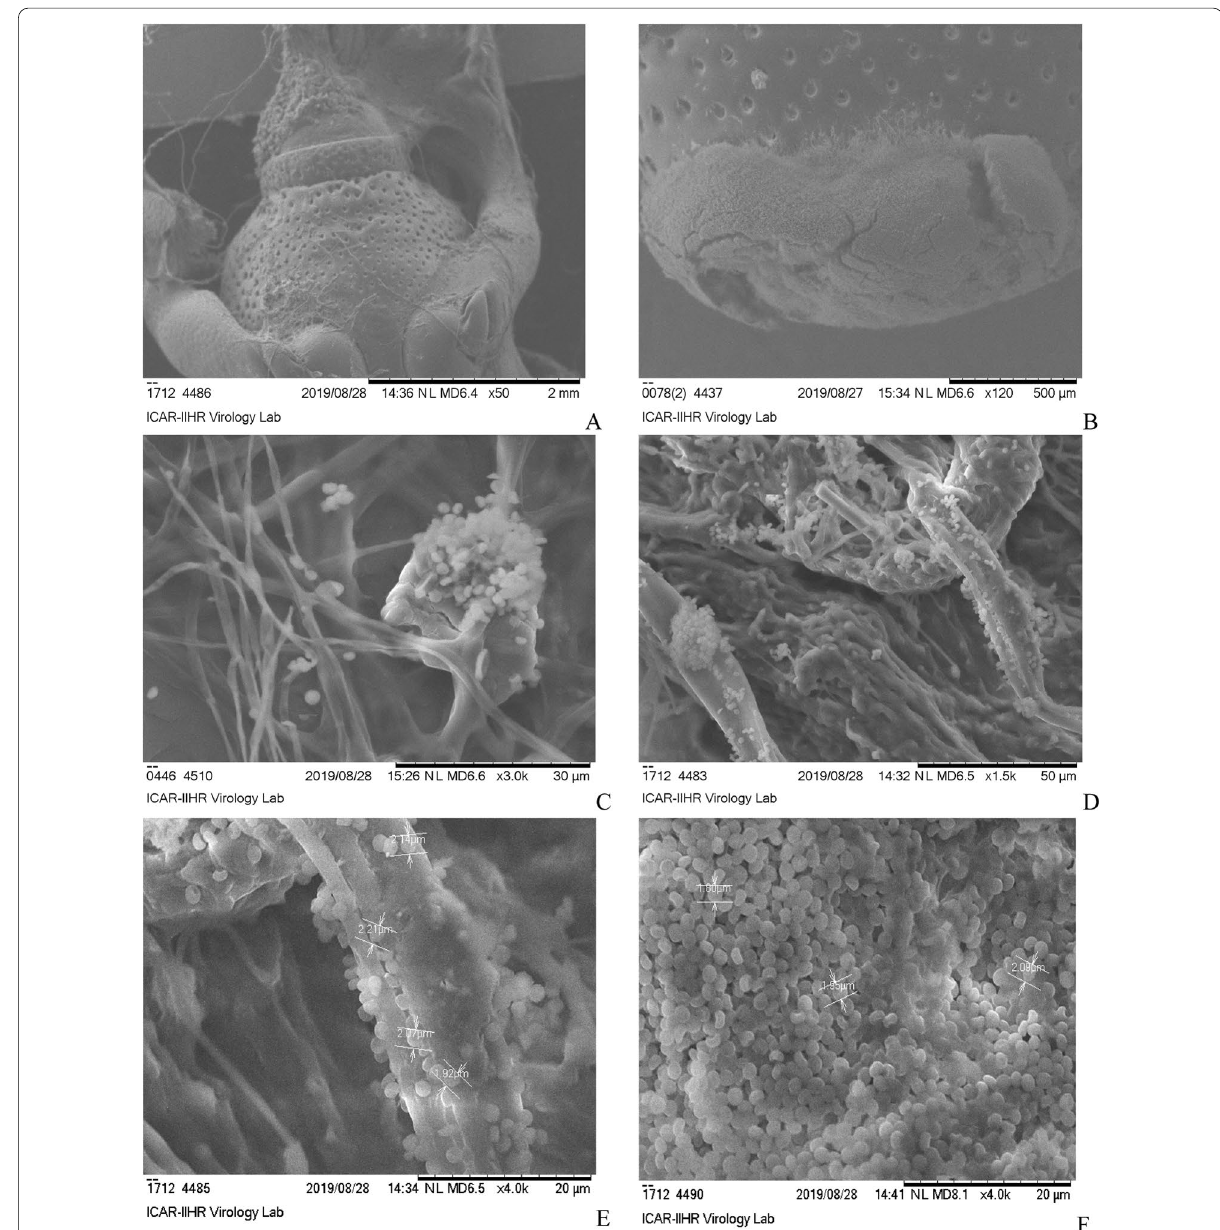
Fig. 1 SEM image showing the process of Beauveria bassiana infection in Odoiporus longicollis . A , B Conidia adhered to the surface of adults insect (2 mm & 500 μm), C , D the cuticle surface of the insect of hyphae (scale par 50 μm), E , F large amount formed in mycelia of B. bassiana (scale par 20 μm & 20